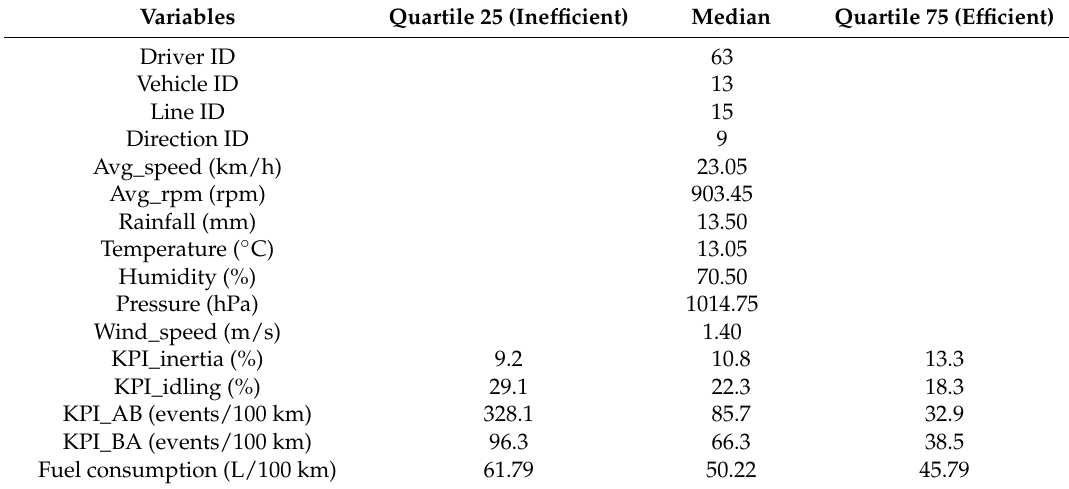
Table 6. Quantitative savings in fuel consumption by improving driving from 25% to